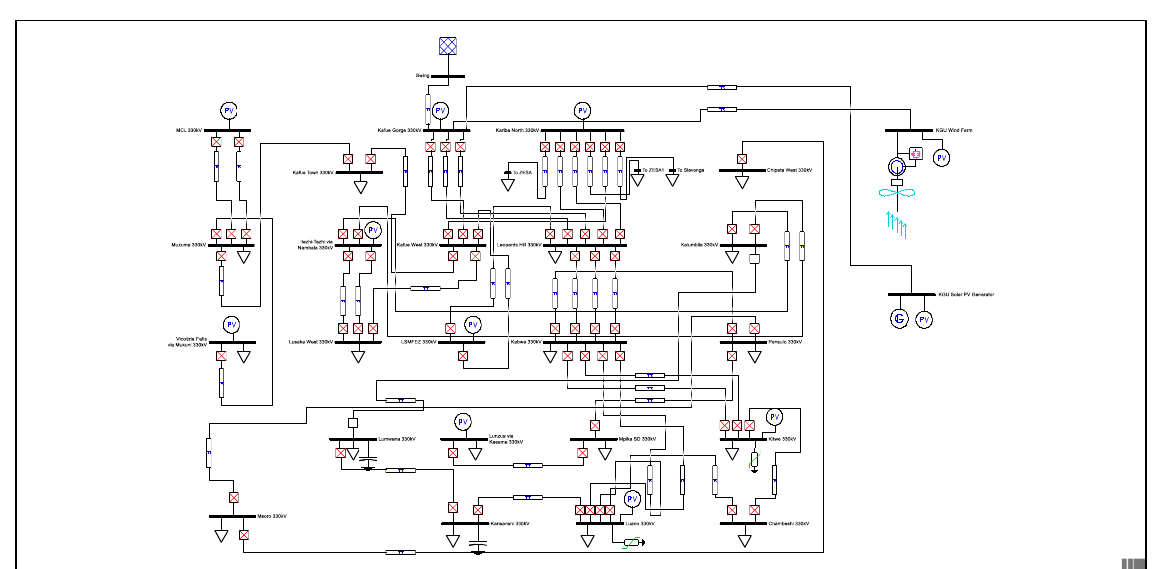
Figure A2. Layout showing the PSAT model for the existing 330 kV Zambian network.